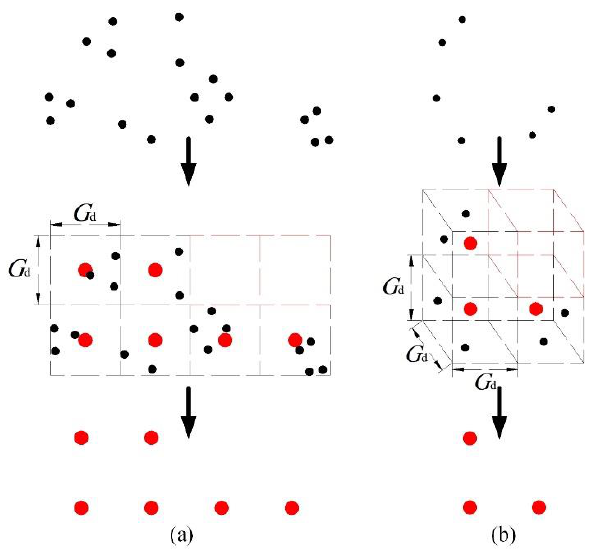
Figure 2 . Examples of converting a point cloud into a grid. a) 2D space, b) 3D space. Top) the point clouds, middle) the boundaries of the grid, bottom) the resulting grid points. The black points are the point cloud. The red points are the grid